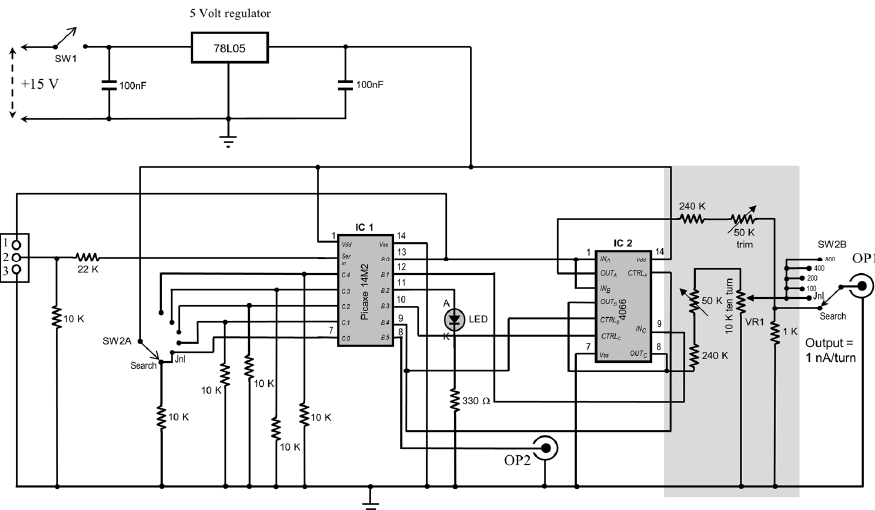
Figure 1. Schematic of the Picaxe microcontroller pulse generator. Main components include IC1 (Picaxe 14M2 microcontroller) and IC2 (CD4066 quad bilateral switch). SW2A and SW2B (function